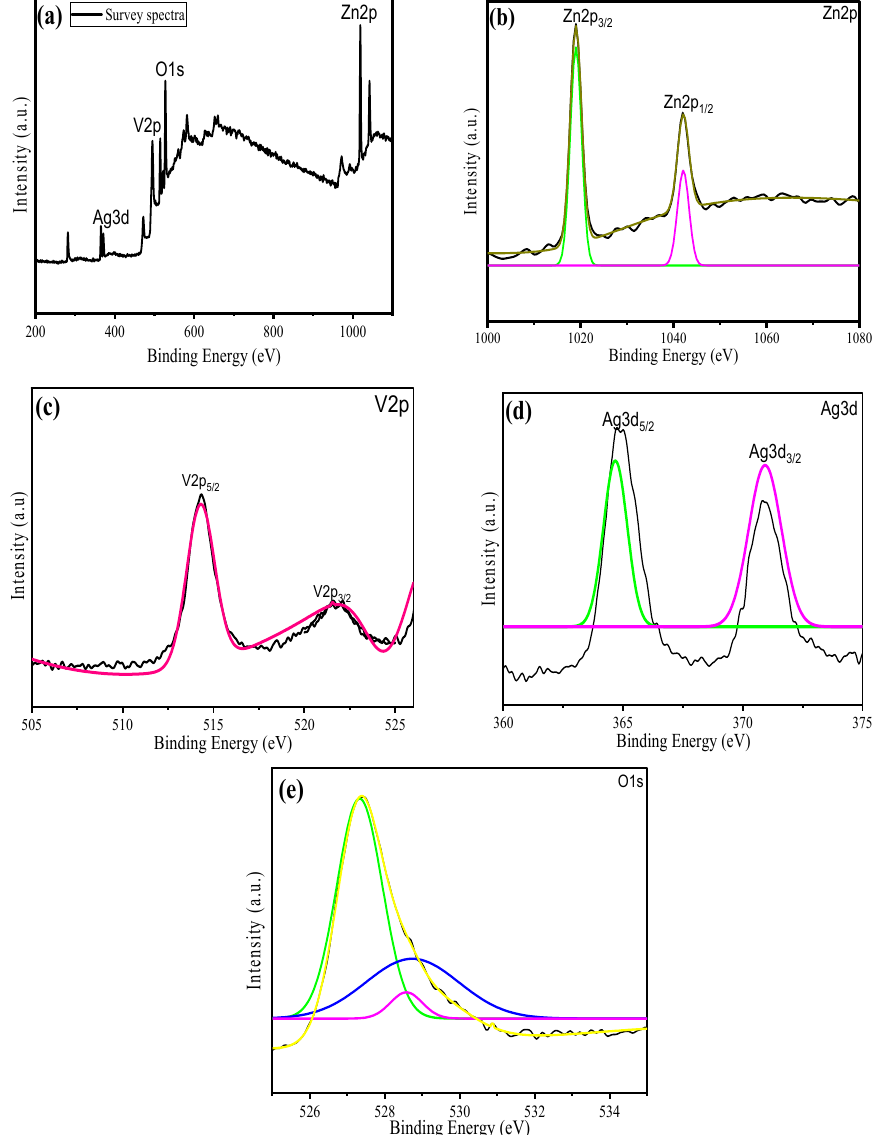
Figure 7. XPS survey spectrum of ZnV@Ag NC: ( a ) Zn2P ( b ), V2p ( c ), Ag3d ( d ), and O1s ( e ) of ZnV@Ag.